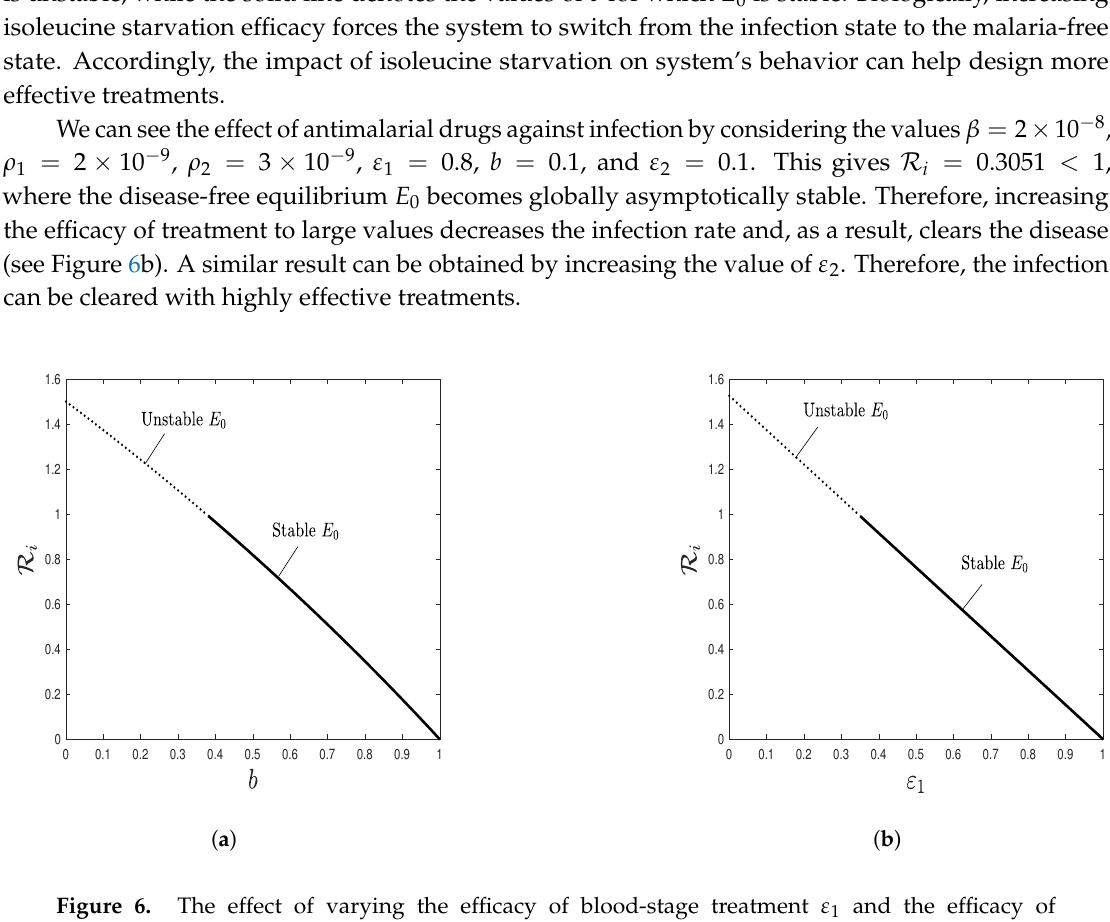
Figure 6. The effect of varying the efficacy of blood-stage treatment ε 1 and the efficacy of isoleucine starvation b on the within-host basic reproductive number R i . The dotted line denotes the values of b for which E 0 is unstable, while the solid line denotes the values of b for which E 0 is stable. ( a ) R i is a nonlinear function of b , where increasing the value of b causes the disease-free equilibrium E 0 to become stable at approximately b = 0.375. ( b ) R i is a linear function of ε 1 , where increasing the value of ε 1 causes the disease-free equilibrium E 0 to become stable at approximately ε 1 =